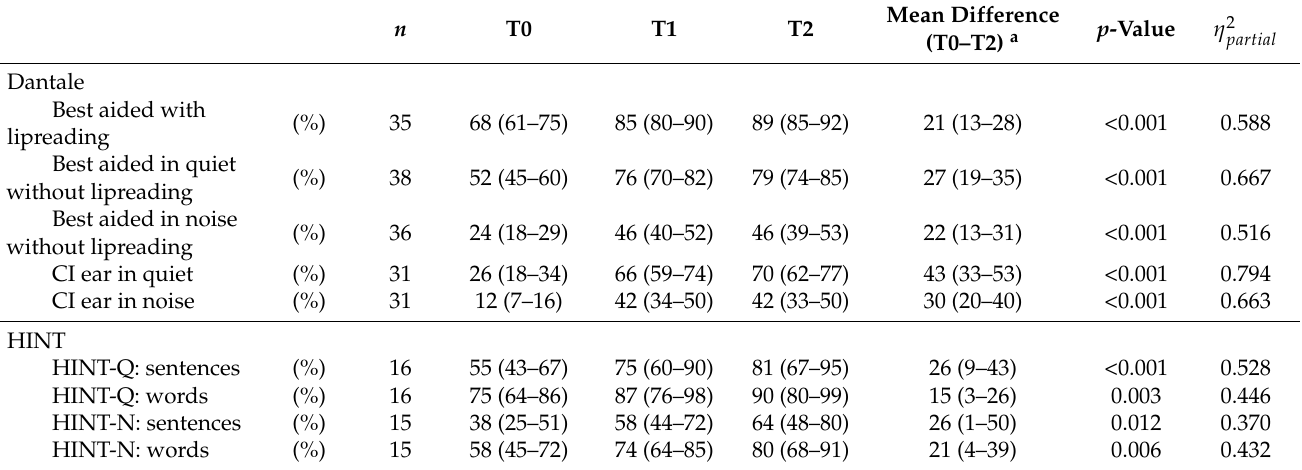
Test scores are presented as means and 95% confidence interval in parantheses; CI: cochlear implant; HINT: Hear- ing in Noise test. a Bonferroni adjusted pairwise comparison between T0 and T2.